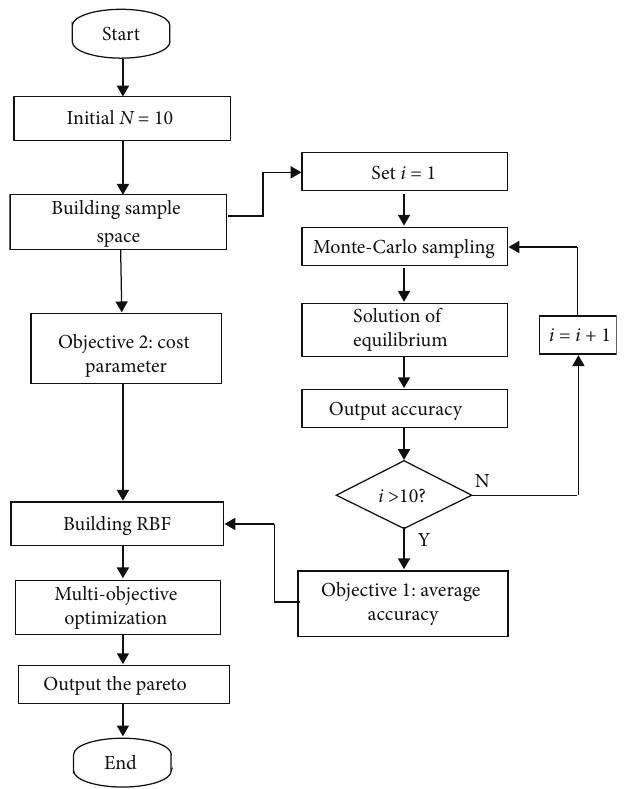
Figure 4: Calculation fl ow chart of the optimal